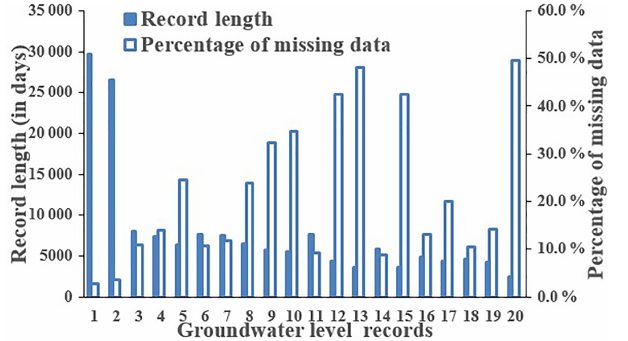
Figure A2. Record lengths (in days) and percentage of missing data for the 20 longest groundwater level records reported in Texas by Water Data for